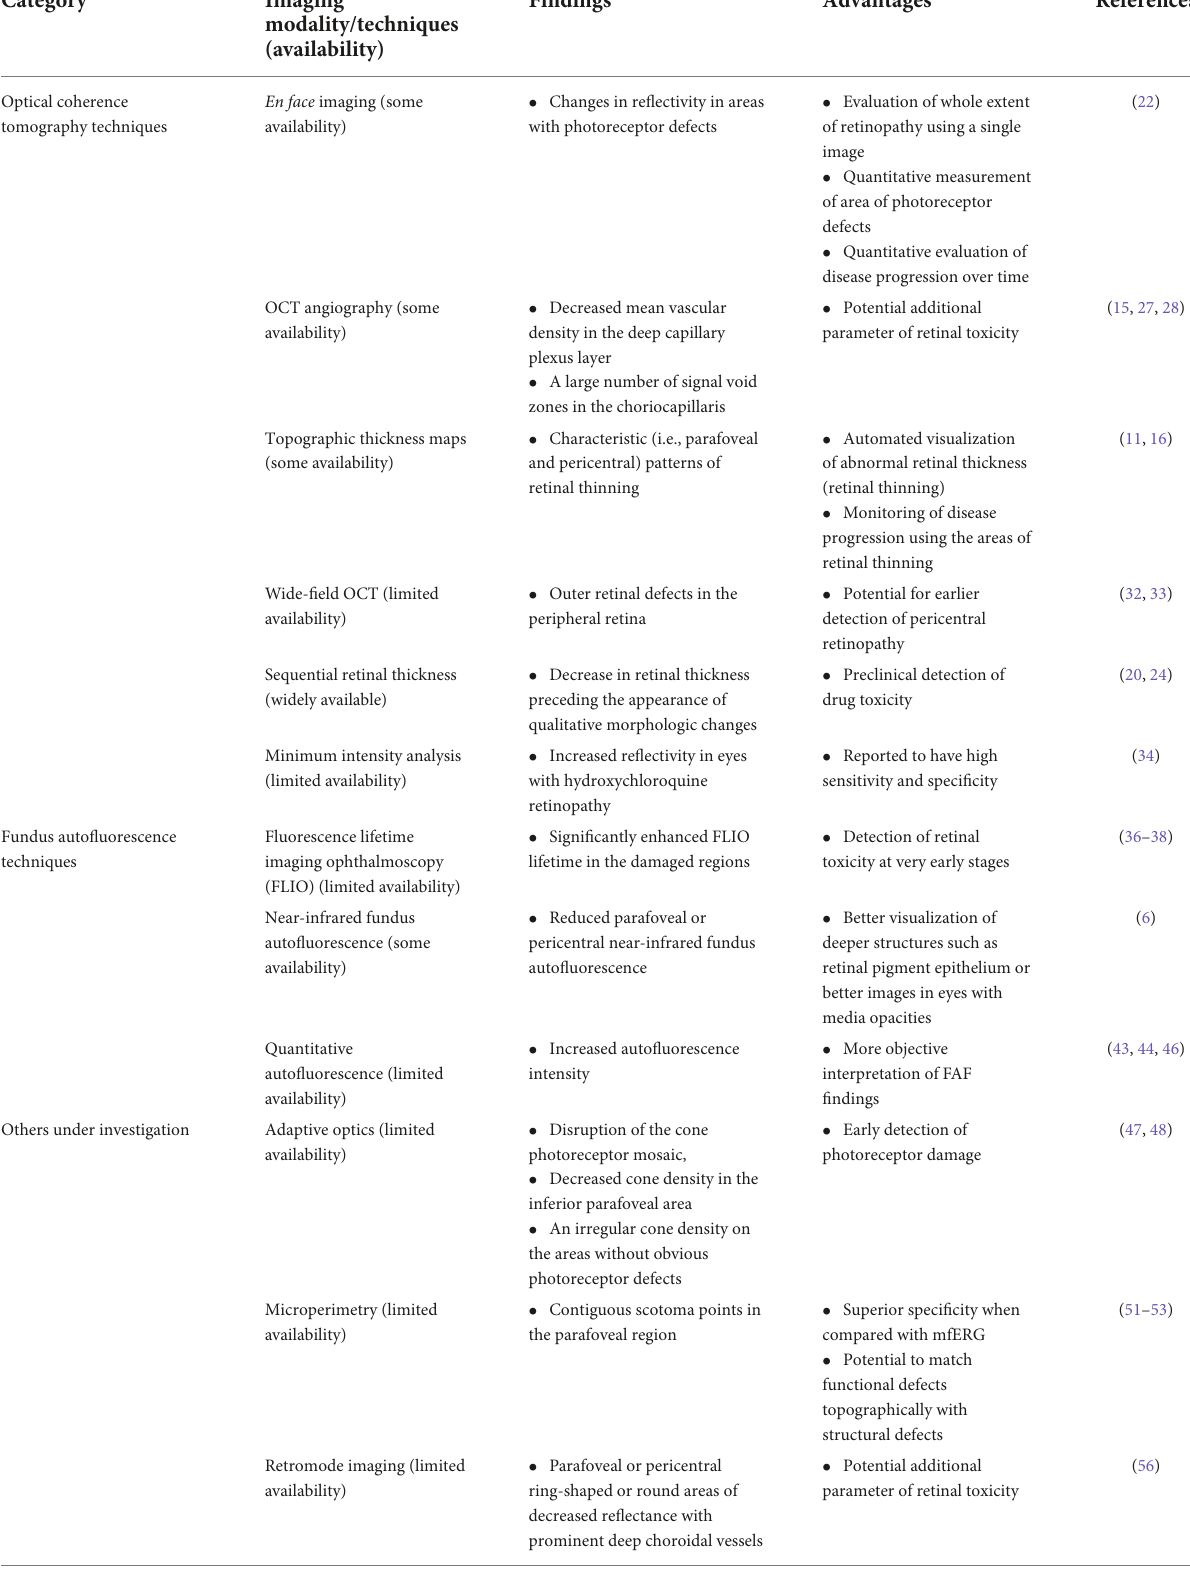
TABLE 2 Novel imaging techniques used for evaluation of hydroxychloroquine retinopathy in the